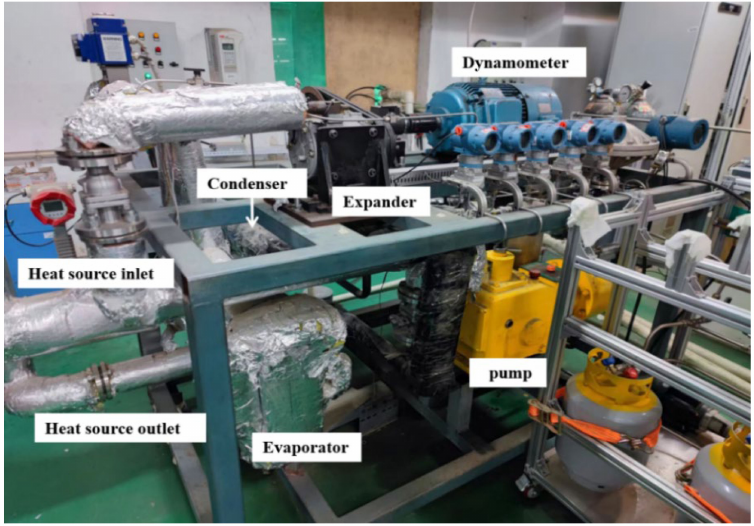
Figure 2. The 4 kW ORC prototype.